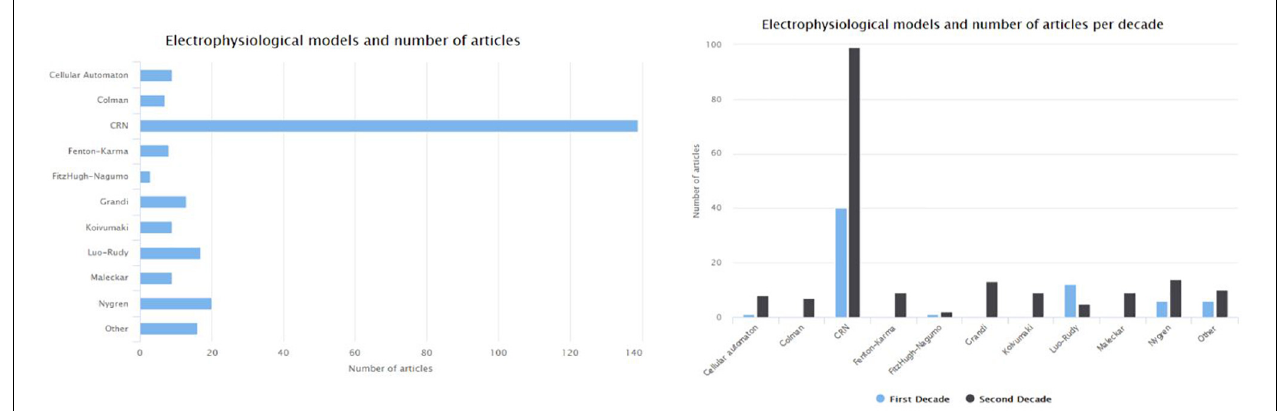
FIGURE 6 | Different electrophysiological models and the number of studies which use them.